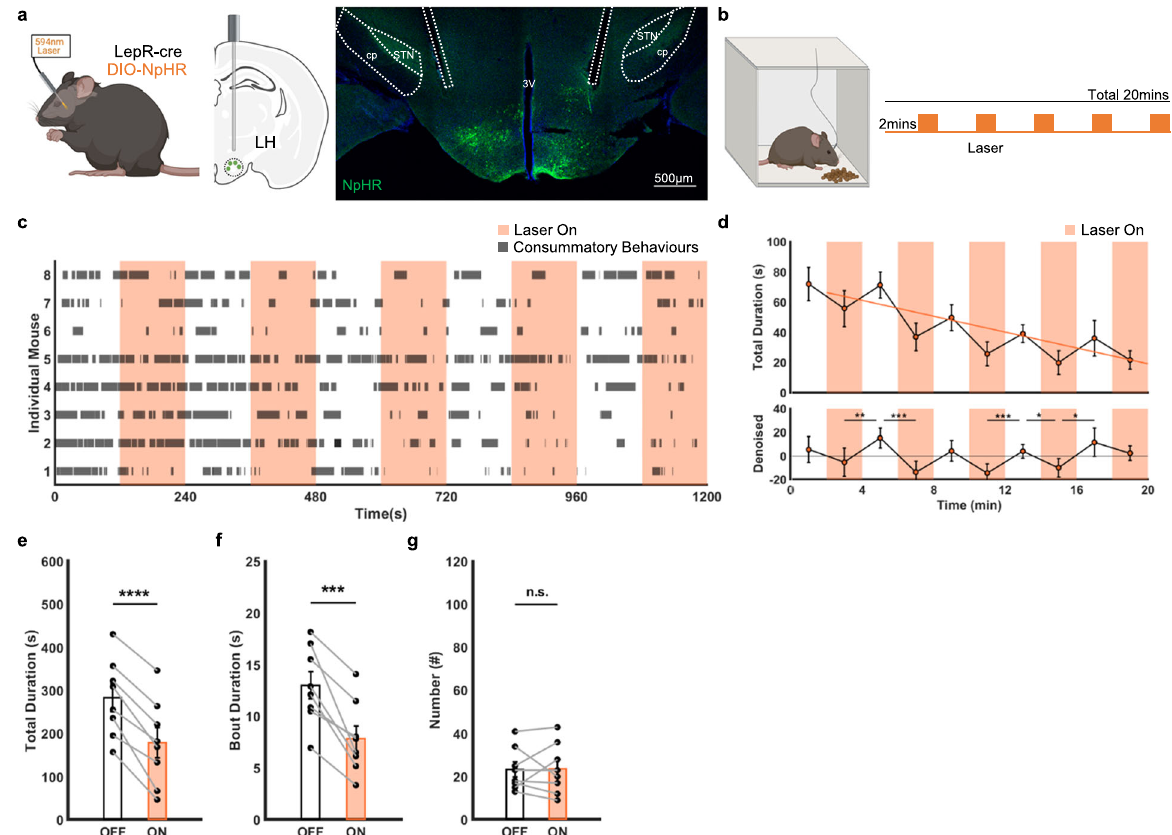
Fig. 5 | Inhibition of LH LepR neurons decreases consummatory behaviours. a Schematicofoptogeneticinhibition(left,middle)andimageofNpHRexpression inLH LepR neurons(right).Theexperimentwasrepeated 8timesindependentlywith similar results. 3V, the 3rd ventricle; STN, subthalamic nucleus; cp, cerebral ped- uncle. b Schematic of the consummatory behaviour test 5 and schedule of laser stimulation. c Raster plot of consummatory behaviours during ( b ) ( n =8 mice). d Averagedurationofconsummatorybehaviours(top).Calibratedgraph (bottom) of the top. Two-sided paired t-test; ** p =0.006 (time bin 2 – 4min vs 4 – 6min),